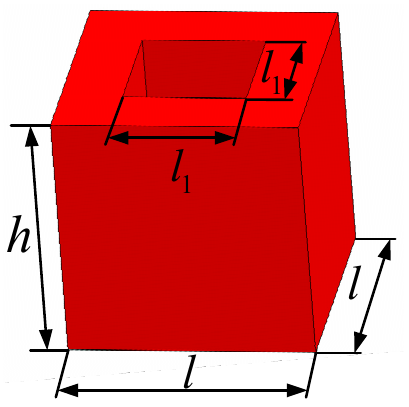
Figure 3. The unit cell.